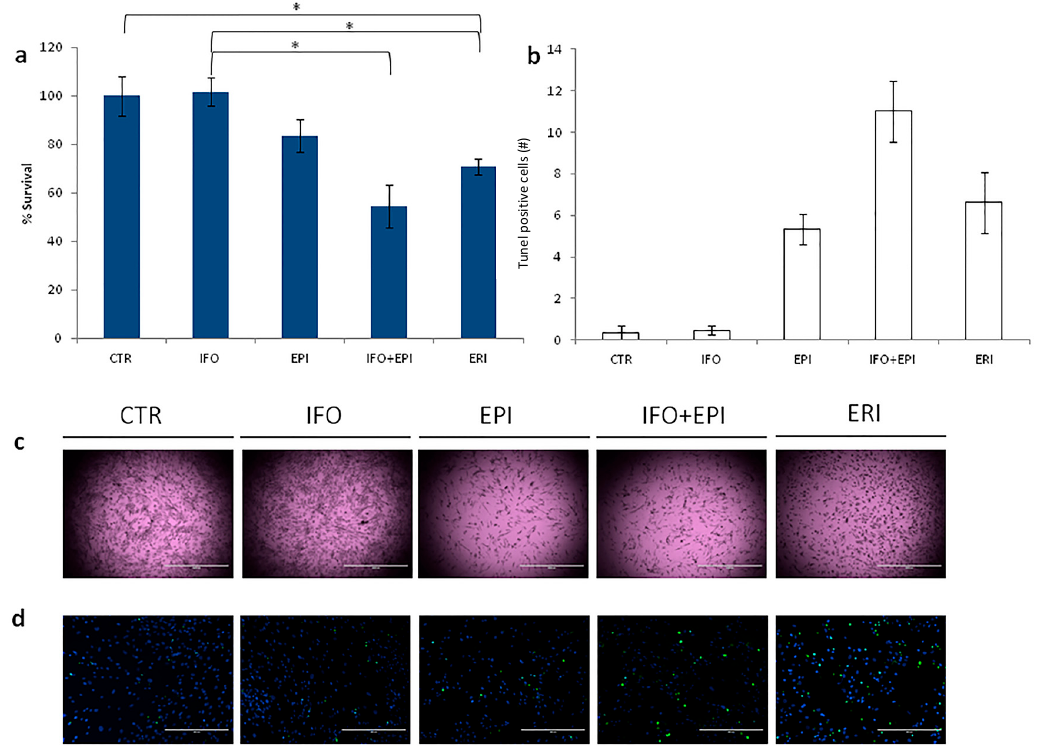
Figure 2. ( a ) Cytotoxicity assay of primary culture treated with: ifosfamide, epirubicin, ifosfamide plus epirubicin and eribulin. Differences between groups were assessed by a two-tailed Student’s t -test, and accepted as significant (*) at p < 0.05; ( b ) Number of tunel-positive cells (green spots) and live cells (blue spots); ( c ) 2 × images of primary culture after the treatment, scale bar 2000 µ m; ( d ) 10 × images of tunel analysis showing apoptotic cells (green spots) and cell nuclei (blue spots), scale bar 400 µ